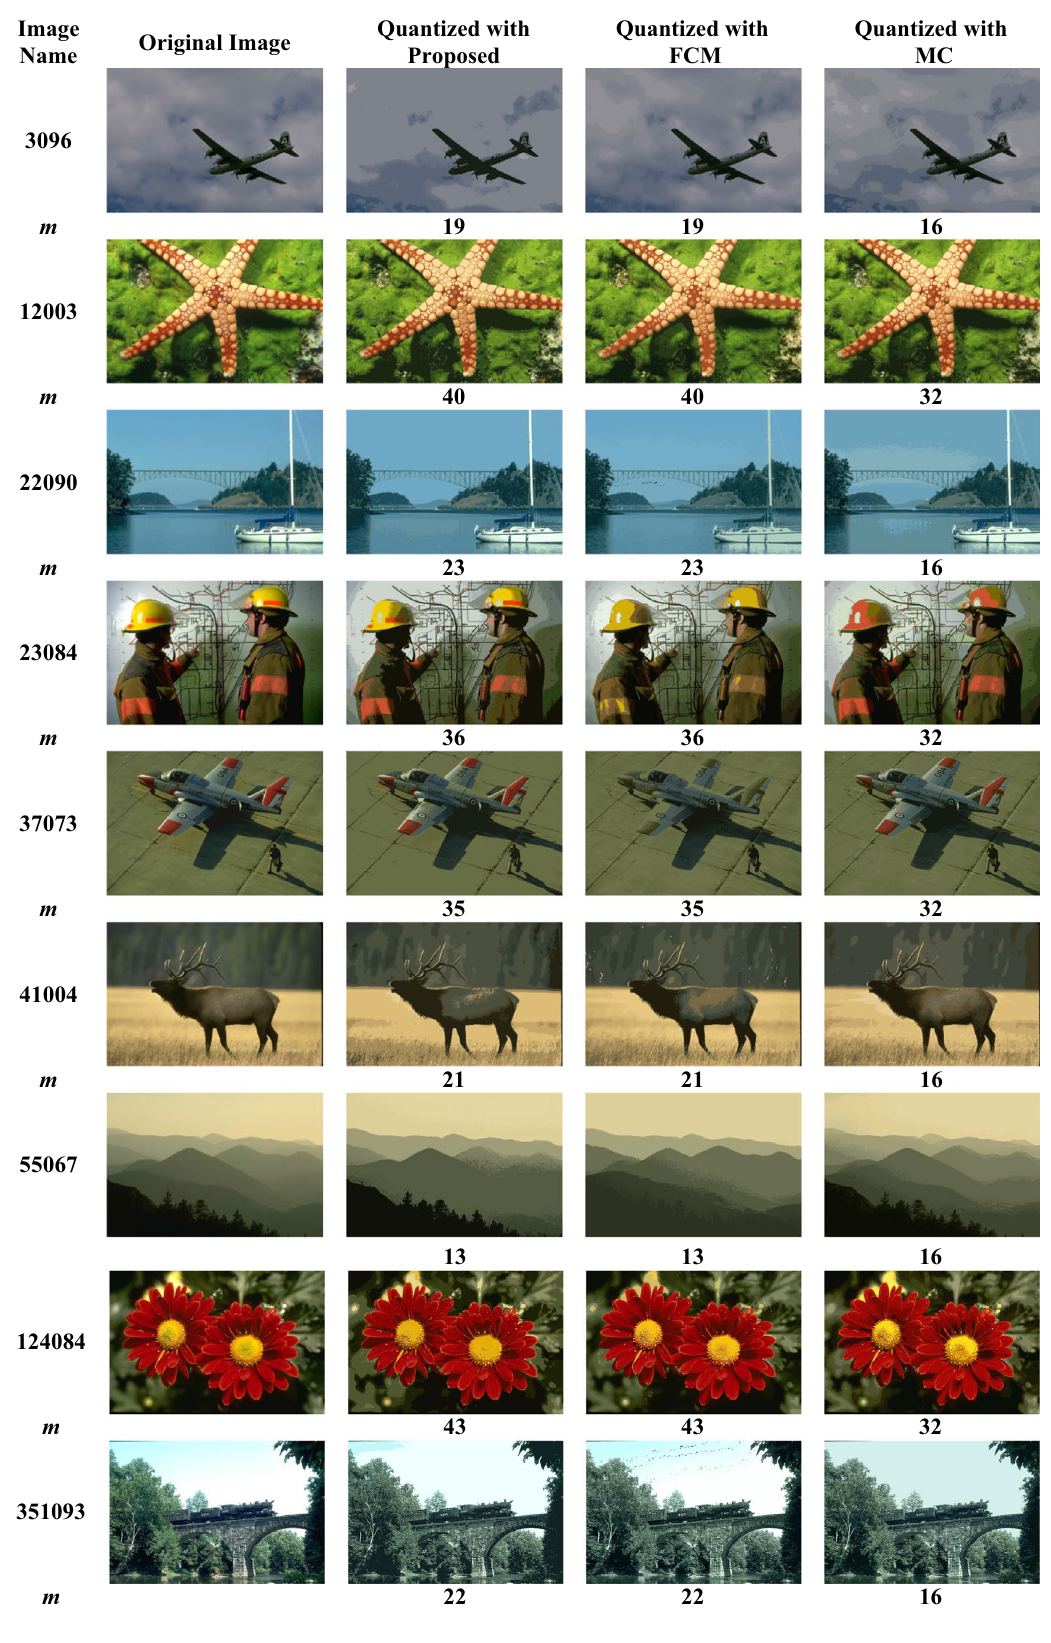
Fig. 5 Original test images and quantized output image with different